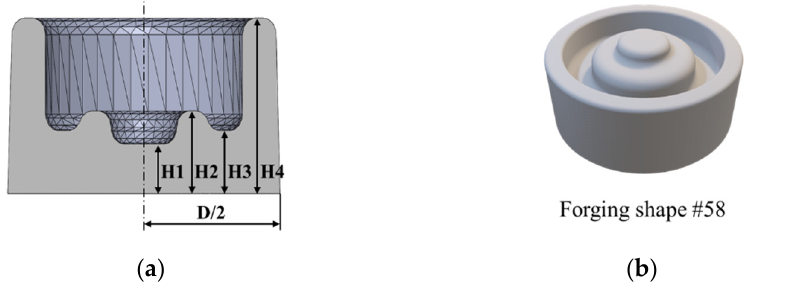
Figure 5. ( a ) Schematic diagram of the geometrical features of the forging shapes, ( b ) forging shape #58 (example).